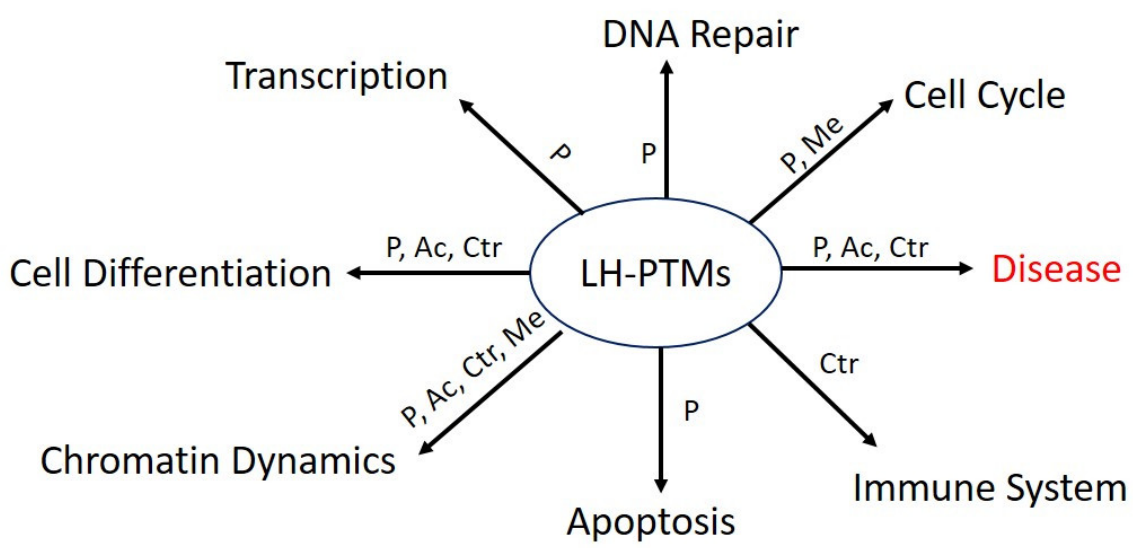
Figure 2. A general overview of involvement of linker histone PTMs in cellular processes; Linker histone PTMs (phosphrorylation (P), acetylation (Ac), methylation (Me), and citrulation (Ctr) have critical involvement in the normal physiological and disease states. Table 1. Post-translation modifications of human linker histone subtypes.